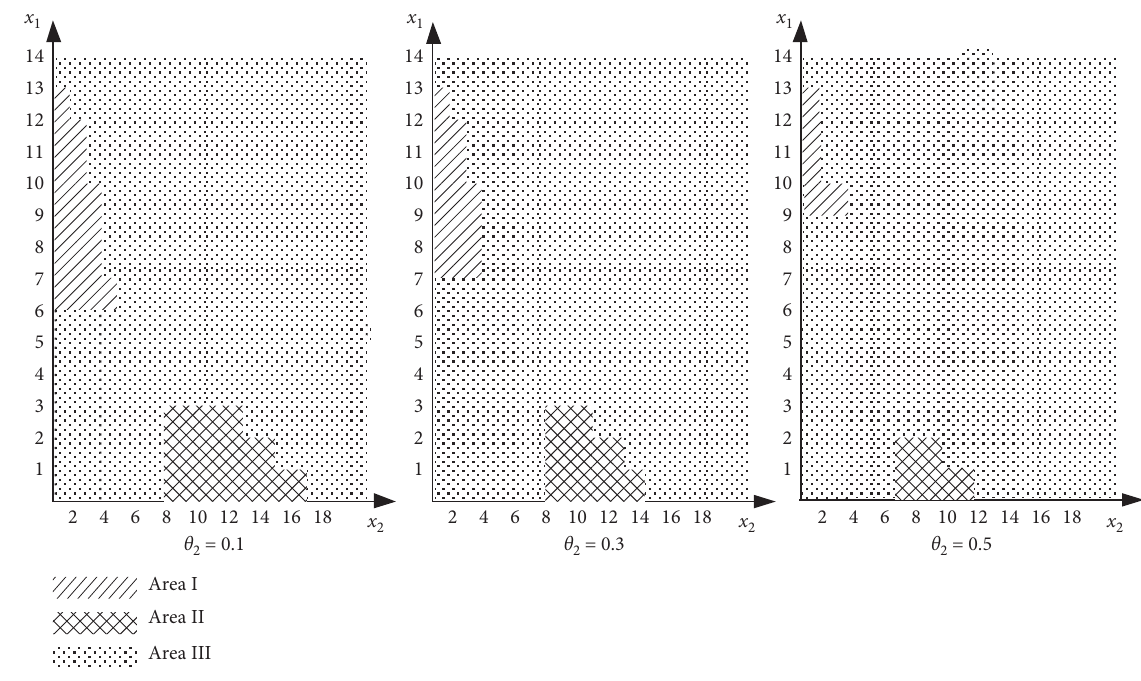
Figure 1: Transshipment area with different switching rates. Table 2: The relationship between the ordering quantities of the two retailers with the switching